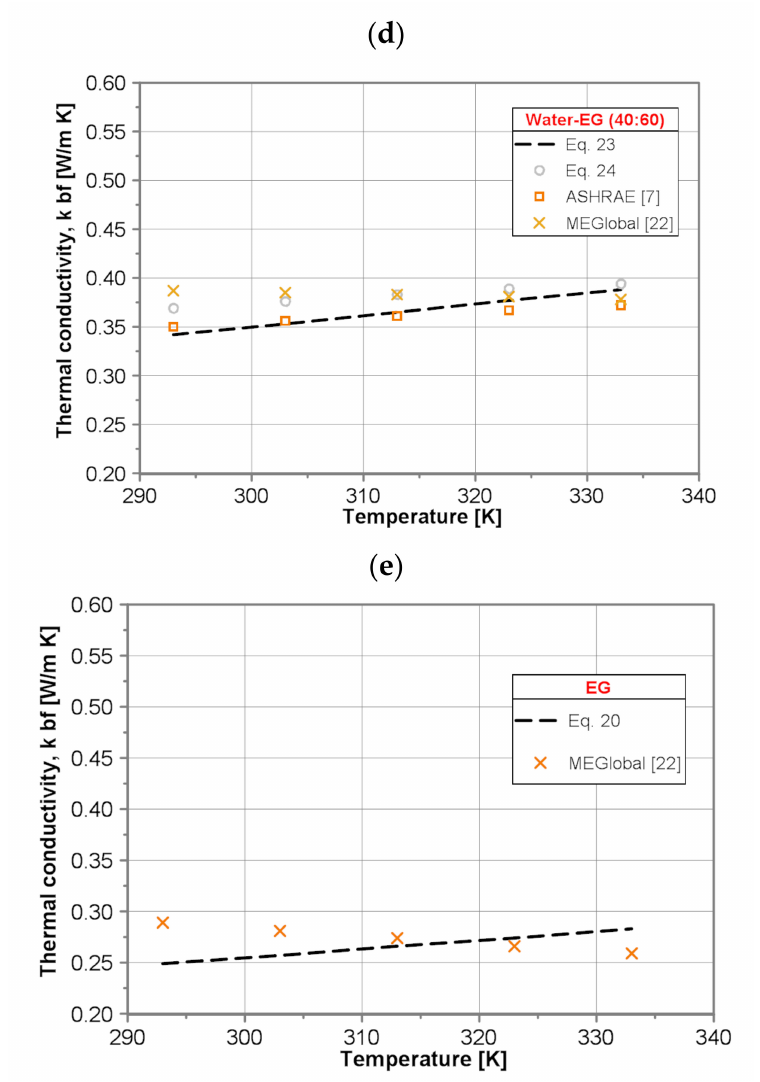
Figure 6. Comparison of the base fluids thermal conductivity: ( a ) water, ( b ) water / EG(60:40), ( c ) water / EG(50:50), ( d ) water / EG(40:60) and ( e )